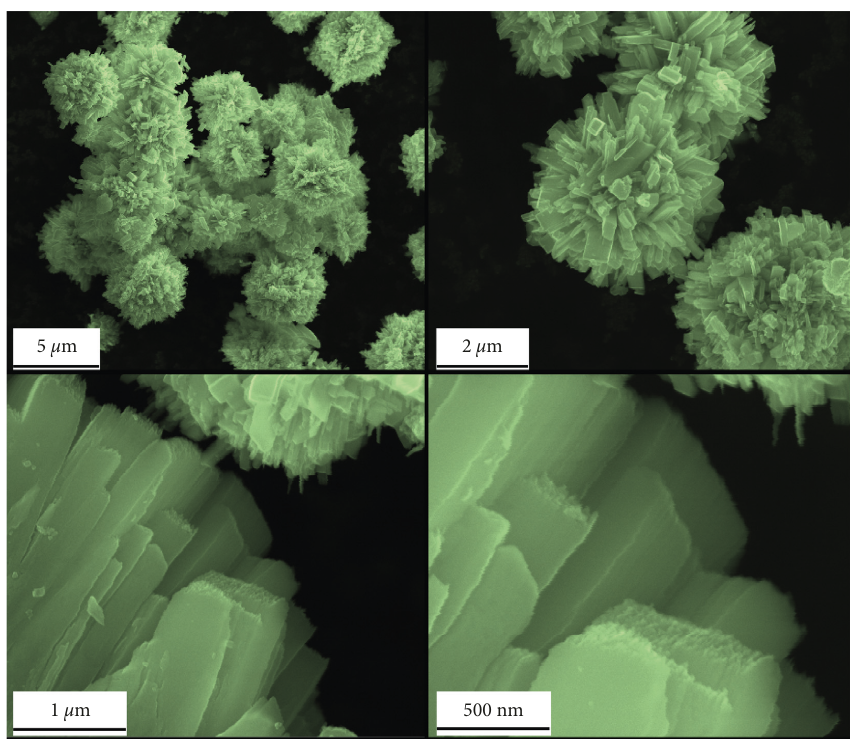
Figure 3: SEM micrographs of the WO 3 -AMT semiconductors, showing the star-like shape and a fine hierarchical structure.